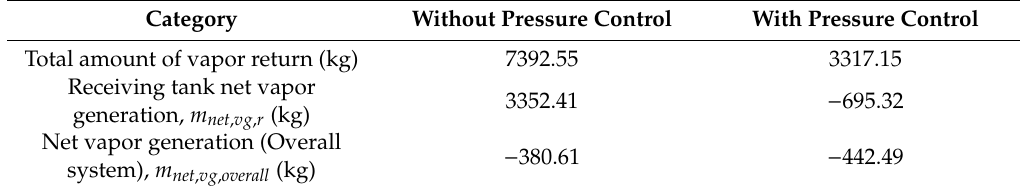
Figure 12. Variation of vapor return flow rate with time. Table 9. Comparison of the evaluated values at the condition of with / without pressure